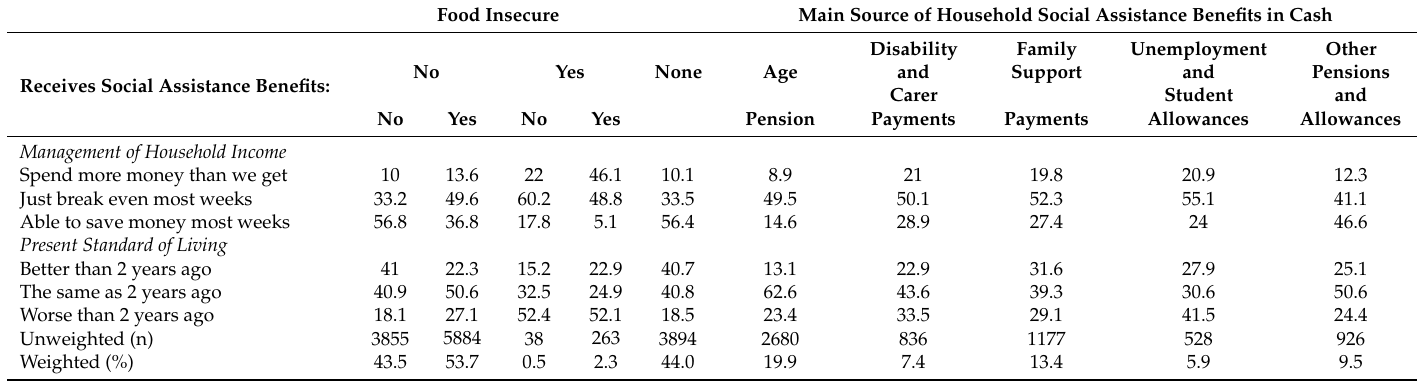
Table A2. Management of Household Income and Standard of Living (%) by Food Insecurity Status and Receipt of Social Assistance, Households 2015/2016. Food Insecure Main Source of Household Social Assistance Benefits in Cash